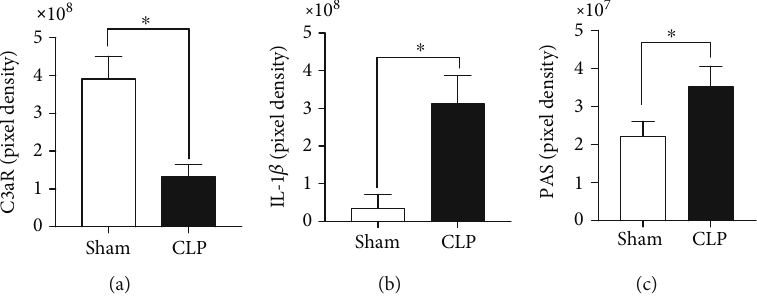
Figure 1: Cardiac physiological, immunological, and damage-associated alterations in vivo in left ventricles of CLP mice: mean pixel density of complement factor 3a receptor (C3aR) (a), interleukin-1 β (IL-1 β ) (b), and glycogen storage in left ventricles in pixel density (c). Mice received sham treatment (white bars) or CLP treatment (black bars) for 24h. Left ventricles were collected 24 h after treatment. n = 5 animals per group; ∗ p < 0 : 05 . All values are expressed as mean ± SEM .